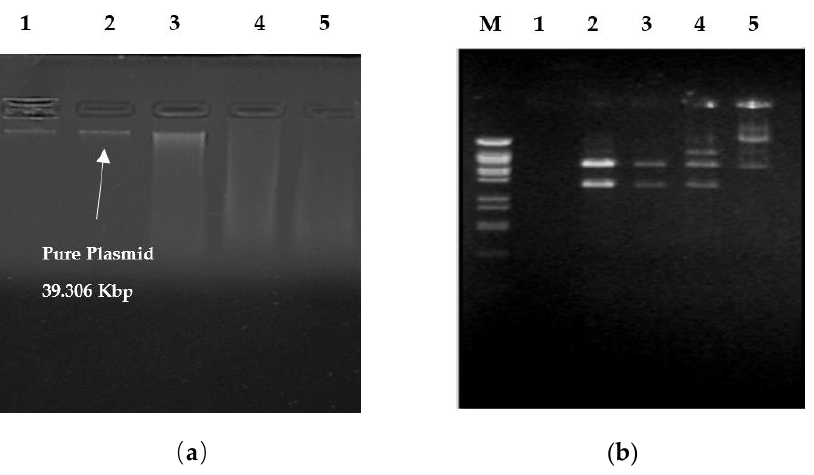
Figure 2. Agarose gel electrophoresis of plasmids obtained from ( a ) pure plasmids of VRSA isolates without cutting and ( b ) VRSA plasmid (Lanes 2–4) restriction arrays digested using the restriction enzymes BamH I , EcoR I , and Hind III , respectively. Lane M is the 100 bp ladder and lane 1 is deionized